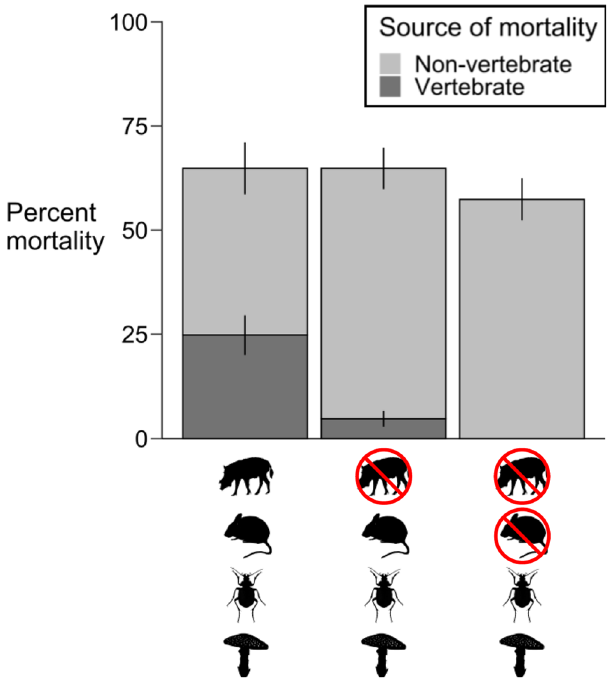
Fig. 3 Source of seed mortality. Total seed mortality did not differ based on the presence or absence of large vertebrates (mixed-effects logistic regression: P = 0.887), even though vertebrate mortality signi fi cantly declined when large animals were excluded ( P < 0.001), due to compensatory predation by fungi and insects. Total mortality also did not change when small mammals were excluded ( P = 0.411). Mortality is de fi ned as seeds that died prior to establishing as seedlings and was calculated across all species ( N = 500 seeds per treatment for each of the fi ve species). Error bars show mean values ± standard errors across experimental blocks ( N = 10).